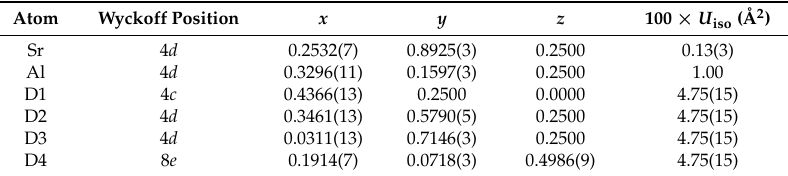
Table 2. Inter-atomic distances of SrAlD 5 . Estimated standard deviations are in parentheses.